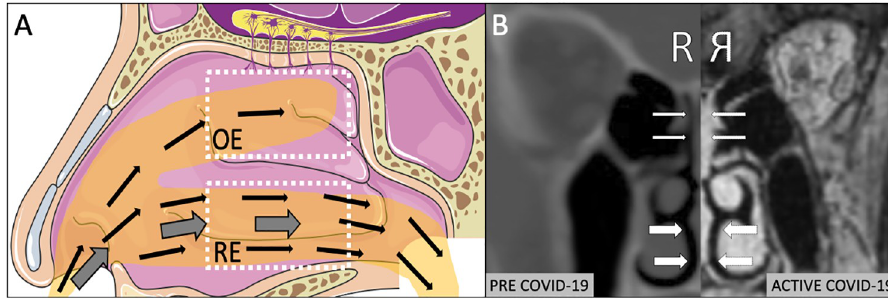
Fig 1. A) Illustration of classic description of airborne aerosols (thin arrows) bypassing the nasal respiratory epithelium (RE) with proposed mechanism for a proportion of these aerosols penetrating into the olfactory epithelium (OE). Thick arrows depict larger-sized aerosolized droplets settling within RE (adapted from Servier Medical Art). B) Matched right sided CT and MRI (reflected) scan of same patient demonstrating new onset isolated inflammation of OE (thin arrows) during COVID-19 infection with sparing of RE (thick